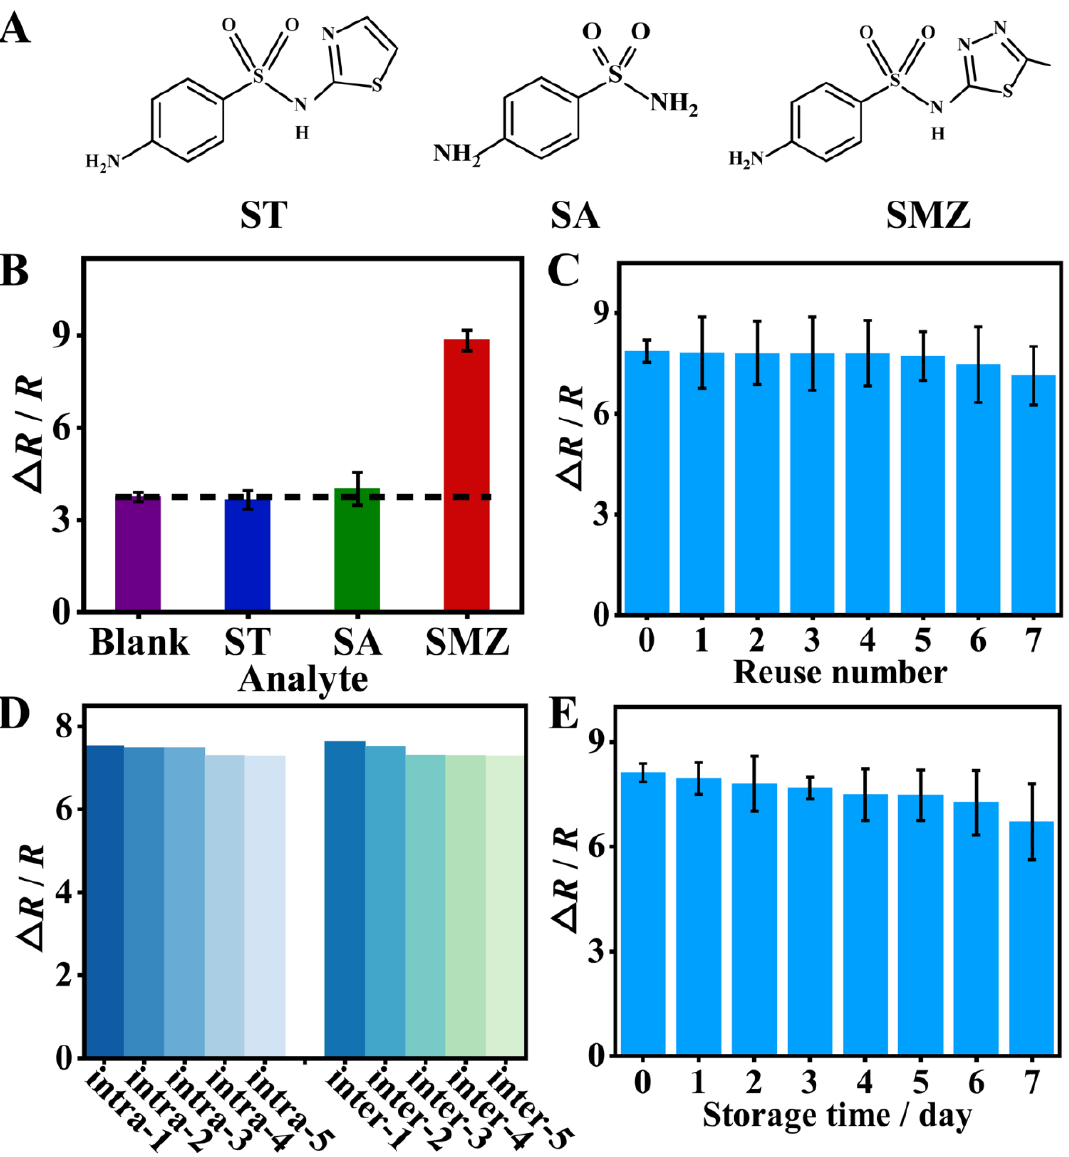
Figure 6. ( A ) Structural formula of sulfathiazole (ST), sulfanilamide (SA), and sulfamethizole (SMZ). ( B ) Selectivity: EIS response of the sensor to ST, SA, and SMZ at the same concentration. ( C ) Reusability: EIS response of the sensor to SMZ (0.1 µ M) with different reuse numbers. ( D ) EIS response of the MIP sensor toward the intra-assay and inter-assay measurements of 0.1 µ M SMZ. ( E ) The storage stability of the MIP/GCE.